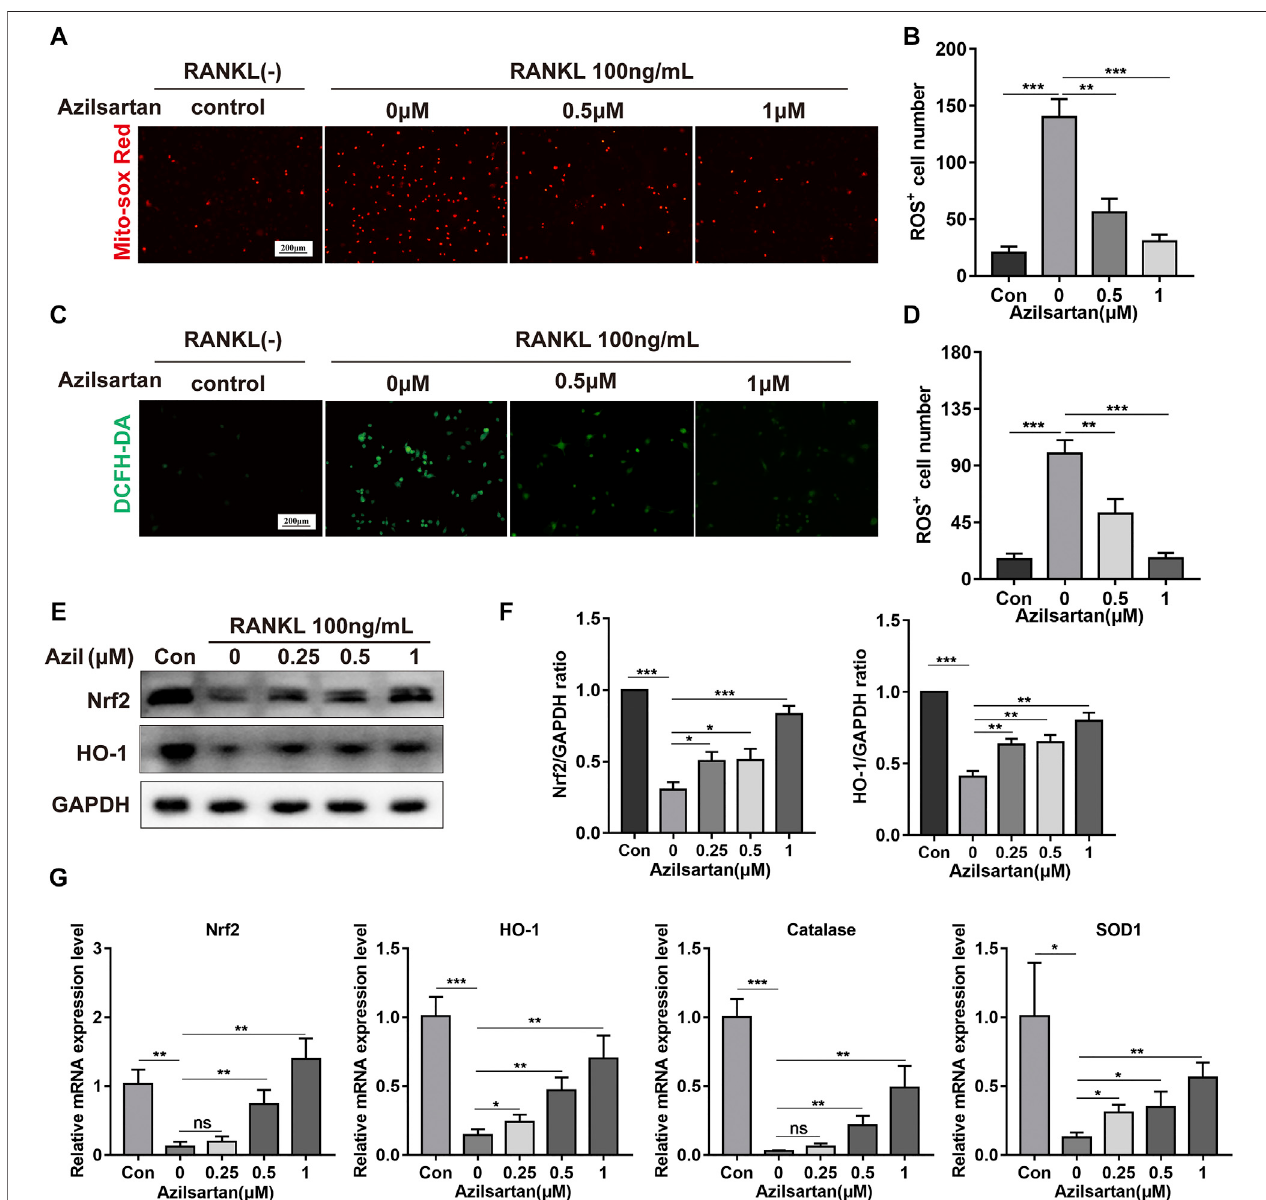
FIGURE 4 | Azilsartan inhibits RANKL-induced ROS production and activates the Nrf2/HO-1 signaling. (A) BMMs were treated with different concentrations of Azilsartan(0,0.5and1 μ M)for48 h,andthenintramitochondrialROSwasdetectedbyMitoSOXRedprobe. (B) QuantitativeanalysisofMitoSOXRed fl uorescence(red) intensity ( n (cid:2) 3). (C) Representative images showing RANKL-induced Intracellular ROS generation in BMMs. (D) Quantitative analysis of DCFH-DA fl uorescence (green) intensity ( n (cid:2) 3). (E) Western blot images showing the effect of Azilsartan on Nrf2/HO-1 signaling. (F) Quantitative analysis of the band intensity of Nrf2 and HO-1 relative to GAPDH using the ImageJ software ( n (cid:2) 3). (G) The speci fi c mRNA expression of Nrf2 , Ho-1 , Catalase , Sod1 ( n (cid:2) 3). All data were obtained from three independent experiments and were shown as mean ± SD. (* p < 0.05, ** p < 0.01, *** p < 0.005, ns, no signi fi cance, compared with the RANKL + 0 μ M Azilsartan group).